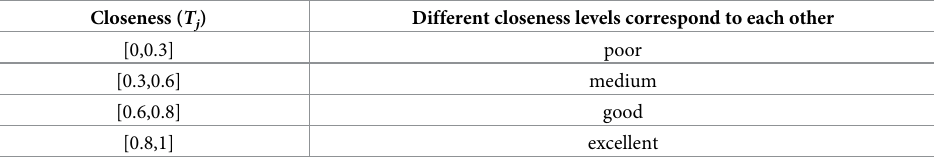
Table 2. Performance evaluation criteria for the management mode of small farmland